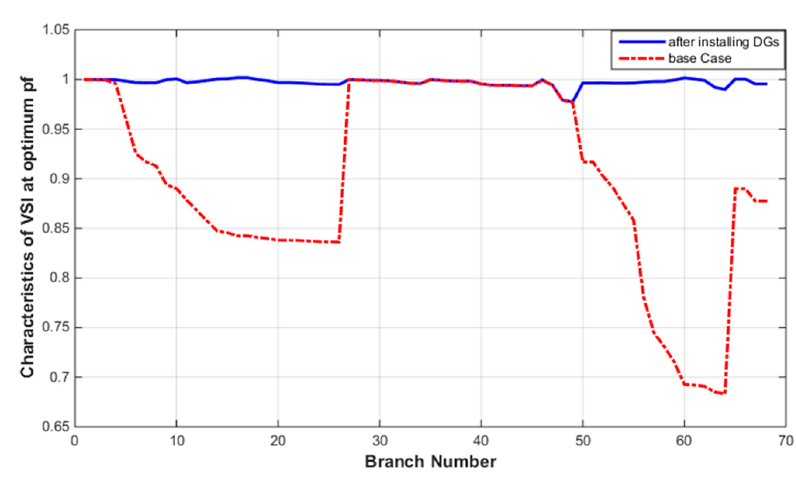
Figure 31. Characteristics of VSI at optimum pf.